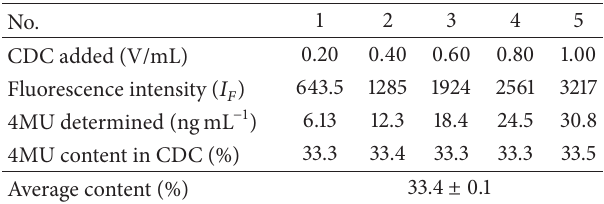
Table 3: Determination of 4MU in CDC by standard curve